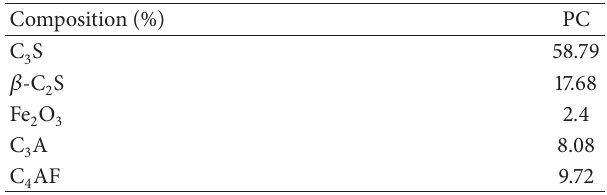
Table 3: The mineralogical composition of Portland cement.